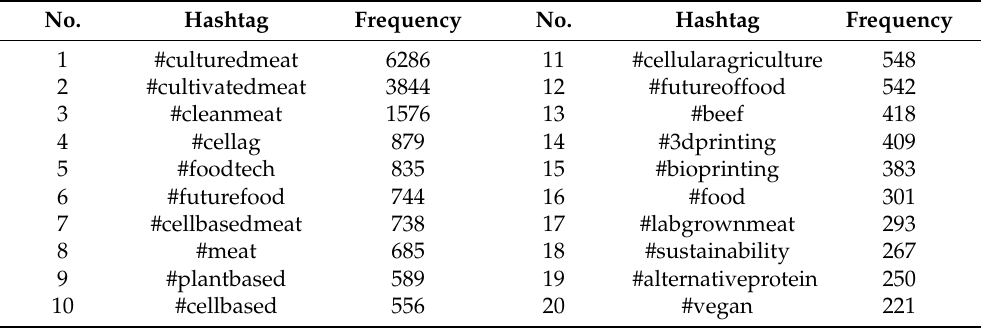
Table 1. Frequency value of the top 20 hashtags published in connection with cultured meat on the social network